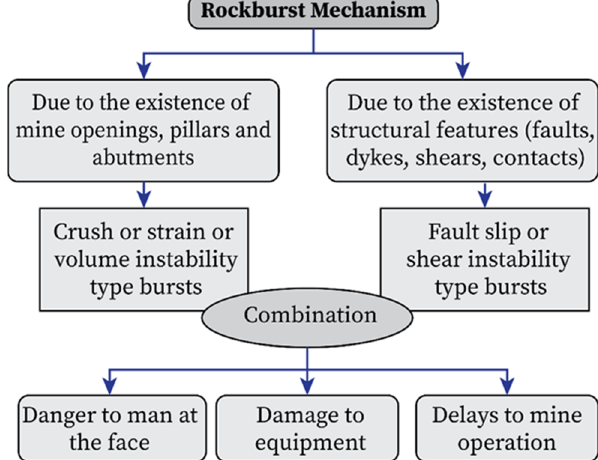
Figure 2. Classification of rockburst mechanisms [52]. Table 3. Rockbursts and their properties